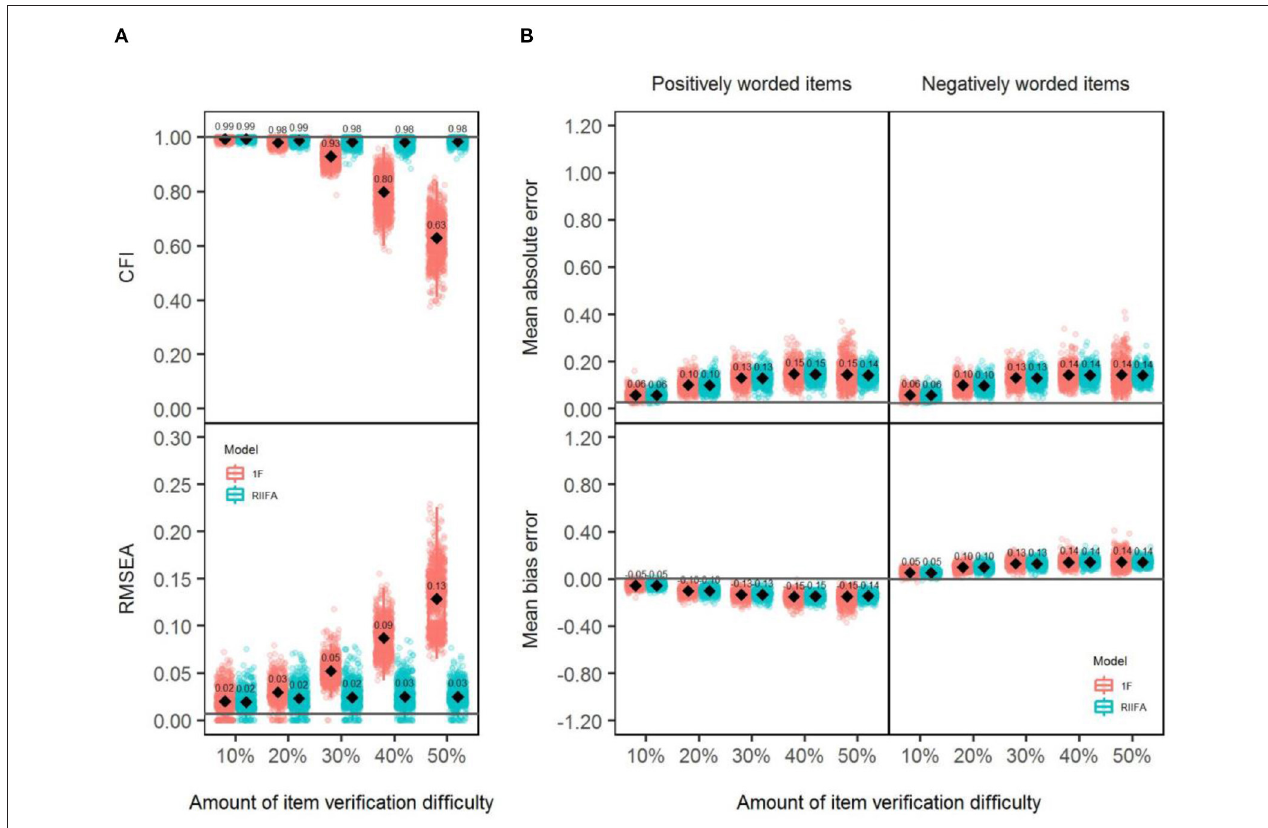
FIGURE 5 | Model fit and recovery of substantive factor loadings for the 1F model and the RIIFA model in the presence of item verification difficulty. 1F, unidimensional model with one substantive factor; RIIFA, random intercept item factor analysis model with one substantive factor and one wording method factor. In (A) , the horizontal gray lines represent the mean CFI and RMSEA values for the condition with 0% of wording effect. In (B) , the horizontal gray lines represent the mean absolute error and the mean bias error for the condition with 0% of wording